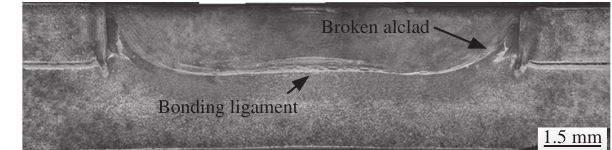
Figure 16: Cross-sections of the joint using